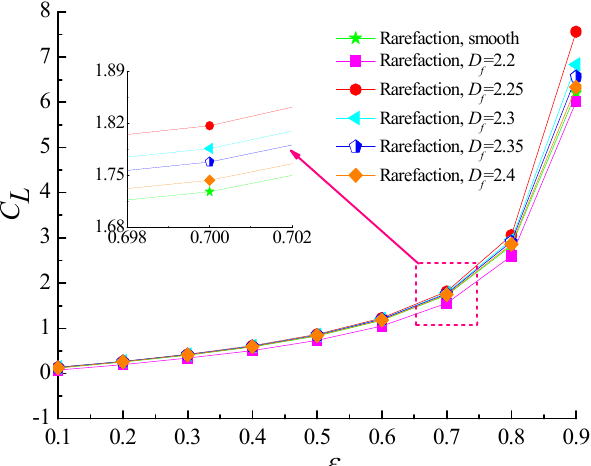
Figure 6. Non-dimensional load capacity versus eccentricity ratio for different fractal dimensions at Λ = 20, G = 1 × 10 −11 .